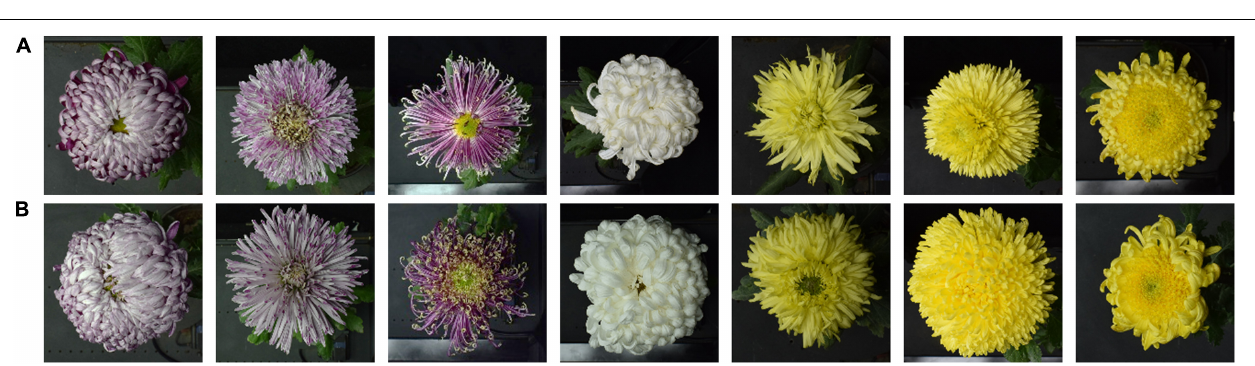
FIGURE 3 | Sample images from dataset training and validation. (A,B) Are training and validation dataset, respectively.